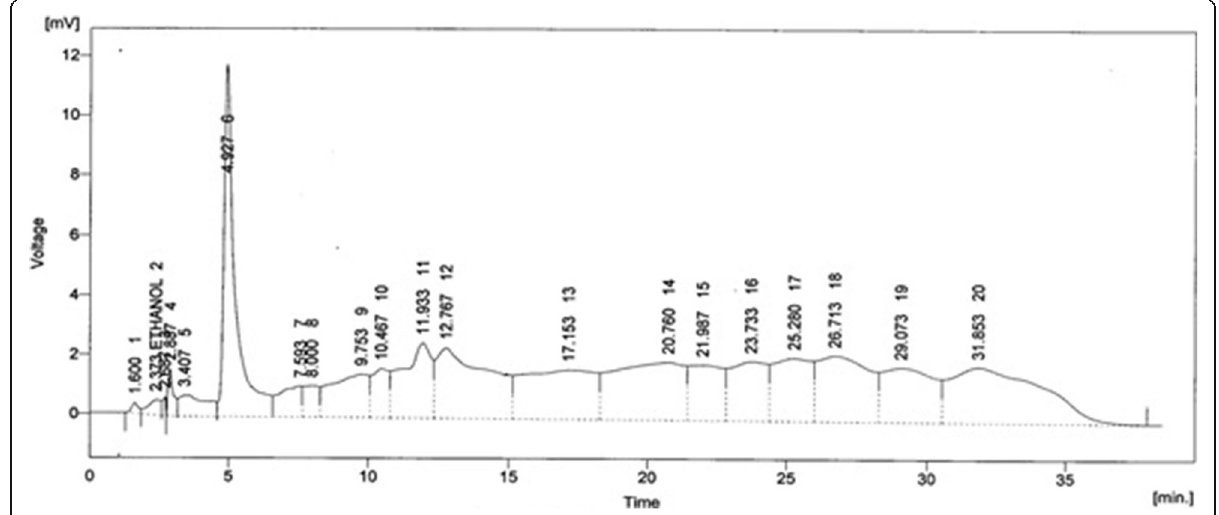
Fig. 9 HPLC chromatogram of n -butanol fraction of